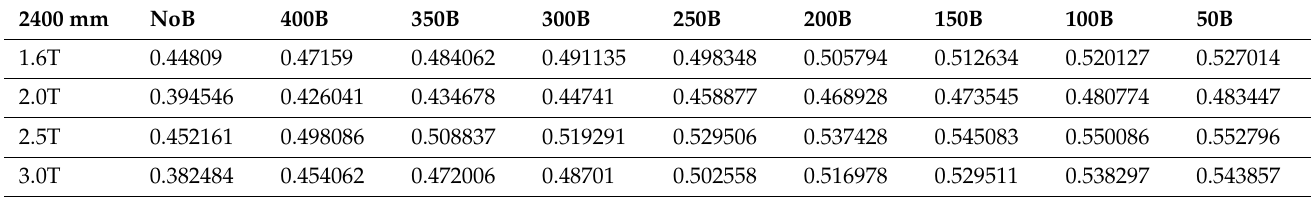
Figure 15. Normalised load-displacement diagrams of the FE results for: ( a ) 1800L-1.6T, ( b ) 1800L-2.0T, ( c ) 1800L-2.5T, and ( d ) 1800L-3.0T models. Table 3. Ultimate normalised compressive capacities for 2400 mm models based on reinforcement spacing.